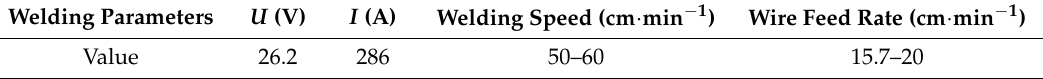
Table 1. Welding condition parameters.